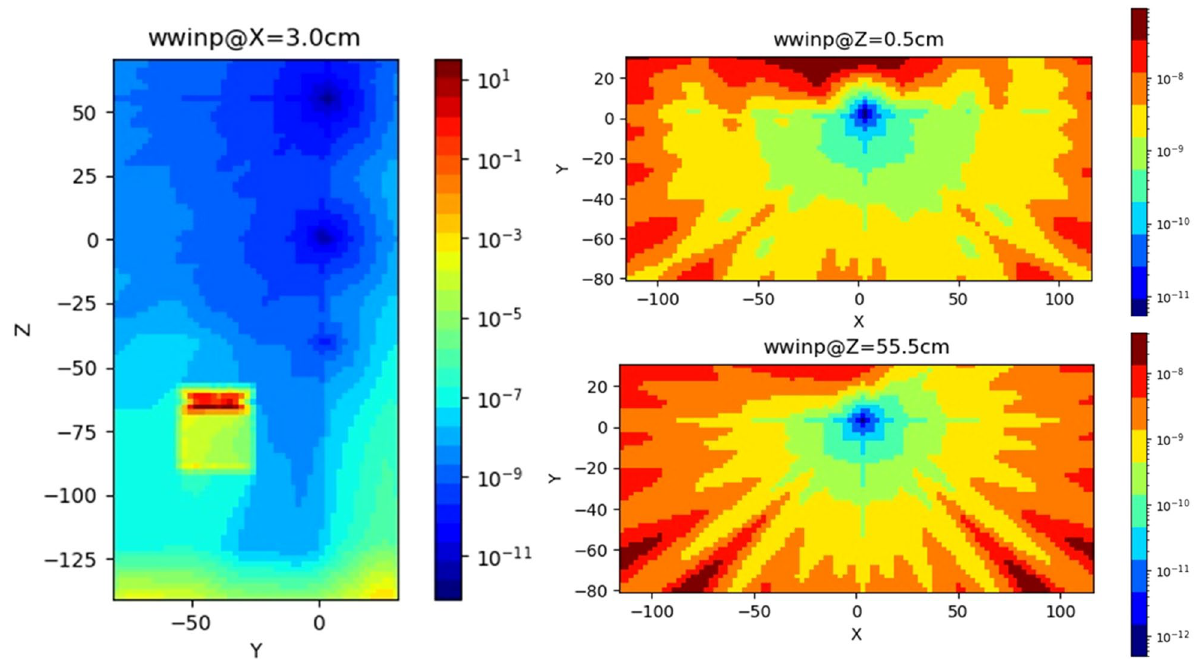
Figure 4. Typical WW distributions. Left, YZ view. Right-up, XY view, chest detector quote (2A). Right-low, XY view, eye lens quote (left eye, 1A). The slight asymmetry is due to the source centered in the vertical axis of the reference system and eye lens shifted by 3.5 cm. See Fig. 2a–c for geometry details.